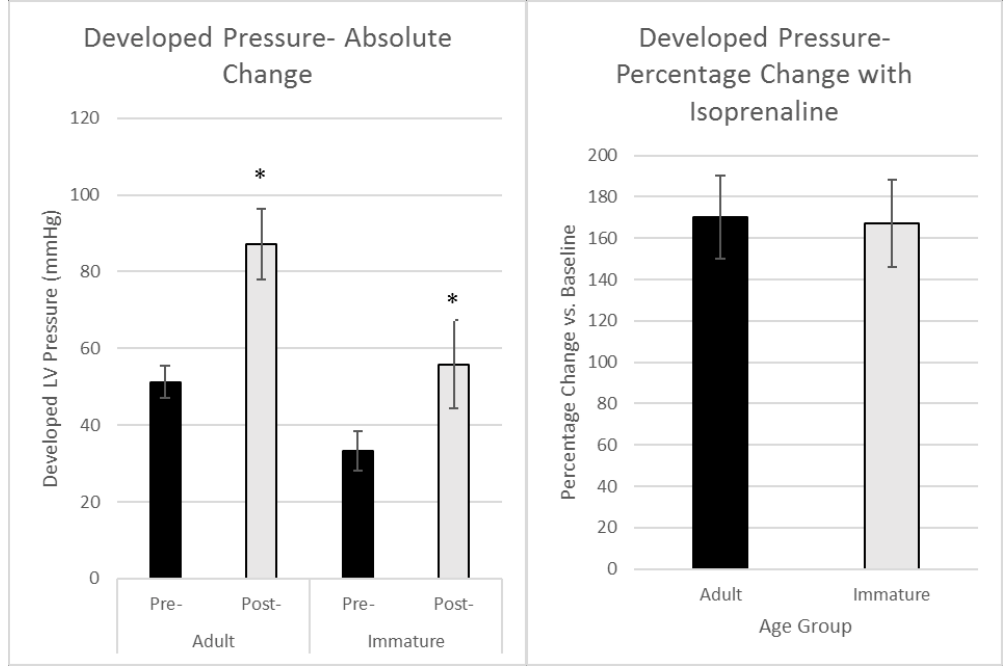
Figure 2. Maximal change in left ventricular developed pressure measured (LVDP) in adult and immature hearts perfused with 5 nM isoproterenol for 3 min. ( Left ) panel; LVDP prior to heart perfusion with isoproterenol (Pre-) and at peak of LVDP following addition of isoproterenol (Post-). ( Right ) panel; proportionate changes of LVDP during heart perfusion with isoproterenol relative to control for each age group. Data points are mean ± SEM of mean. * p < 0.05 vs. corresponding pre- values.